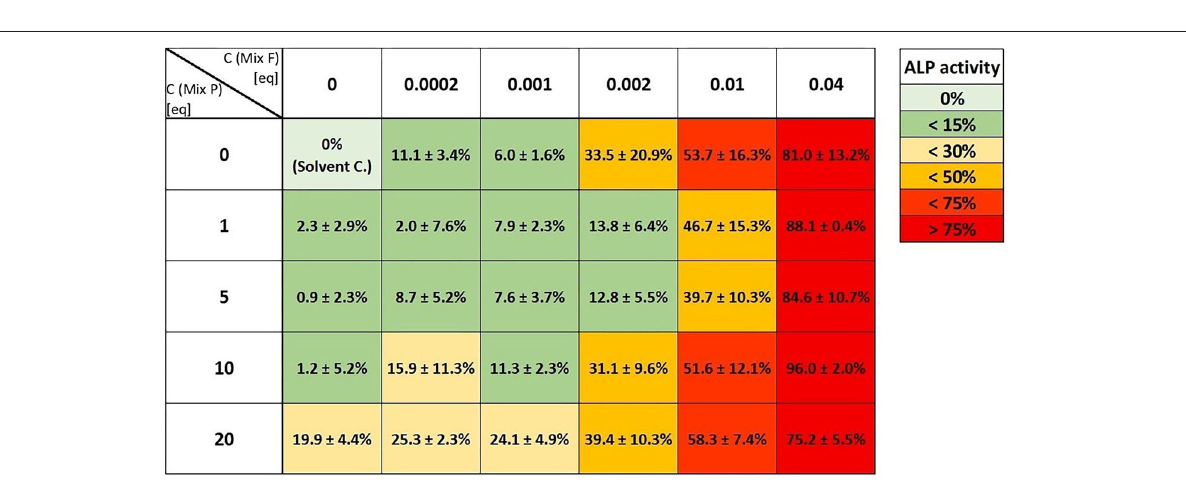
FIGURE 8 | Heat map analysis of the screening approach to assess the combinatory estrogenic effects of combination of the flavonoid mixture (“Mix F”) and the pesticide mixture (“Mix P”) in an array of different concentrations. Values (normalized to both, solvent and positive control) are given as means ± SD of at least three independent